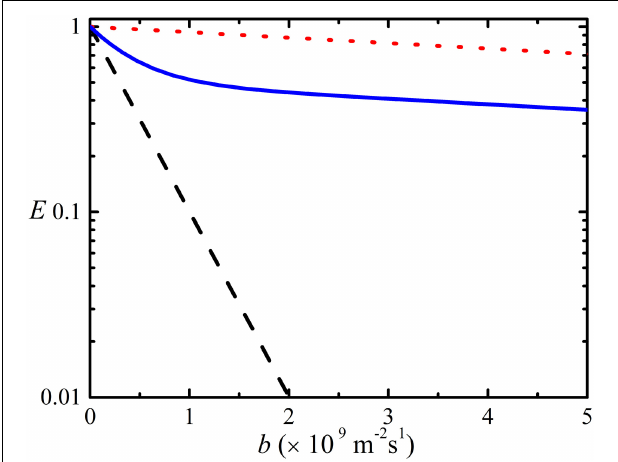
FIGURE 2 | Simulated 1 H echo attenuation plots for a fast diffusing species ( ) such as water (2.3 × 10 − 9 m 2 s − 1 ) in hemoglobin solution, a slowly diffusing species ( ) with a diffusion coefficient of (6.8 × 10 − 11 m 2 s − 1 ) [62]. Also shown is the sum of the attenuation values of the two species ( ) if the signals of fast and slow diffusion species are overlapped and in equal concentration. The simulation was performed with γ = 2 . 67 × 10 8 rad s − 1 T − 1 , (cid:3) = 200ms and δ = 6ms and g ranging from 0 to 0.20 T m − 1 .